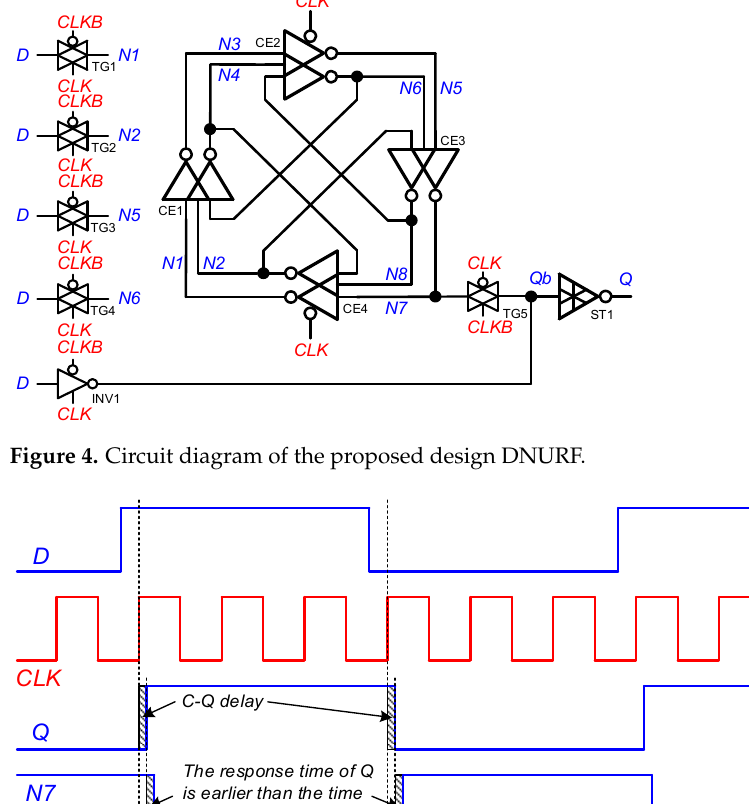
Figure 4. Circuit diagram of the proposed design DNURF.